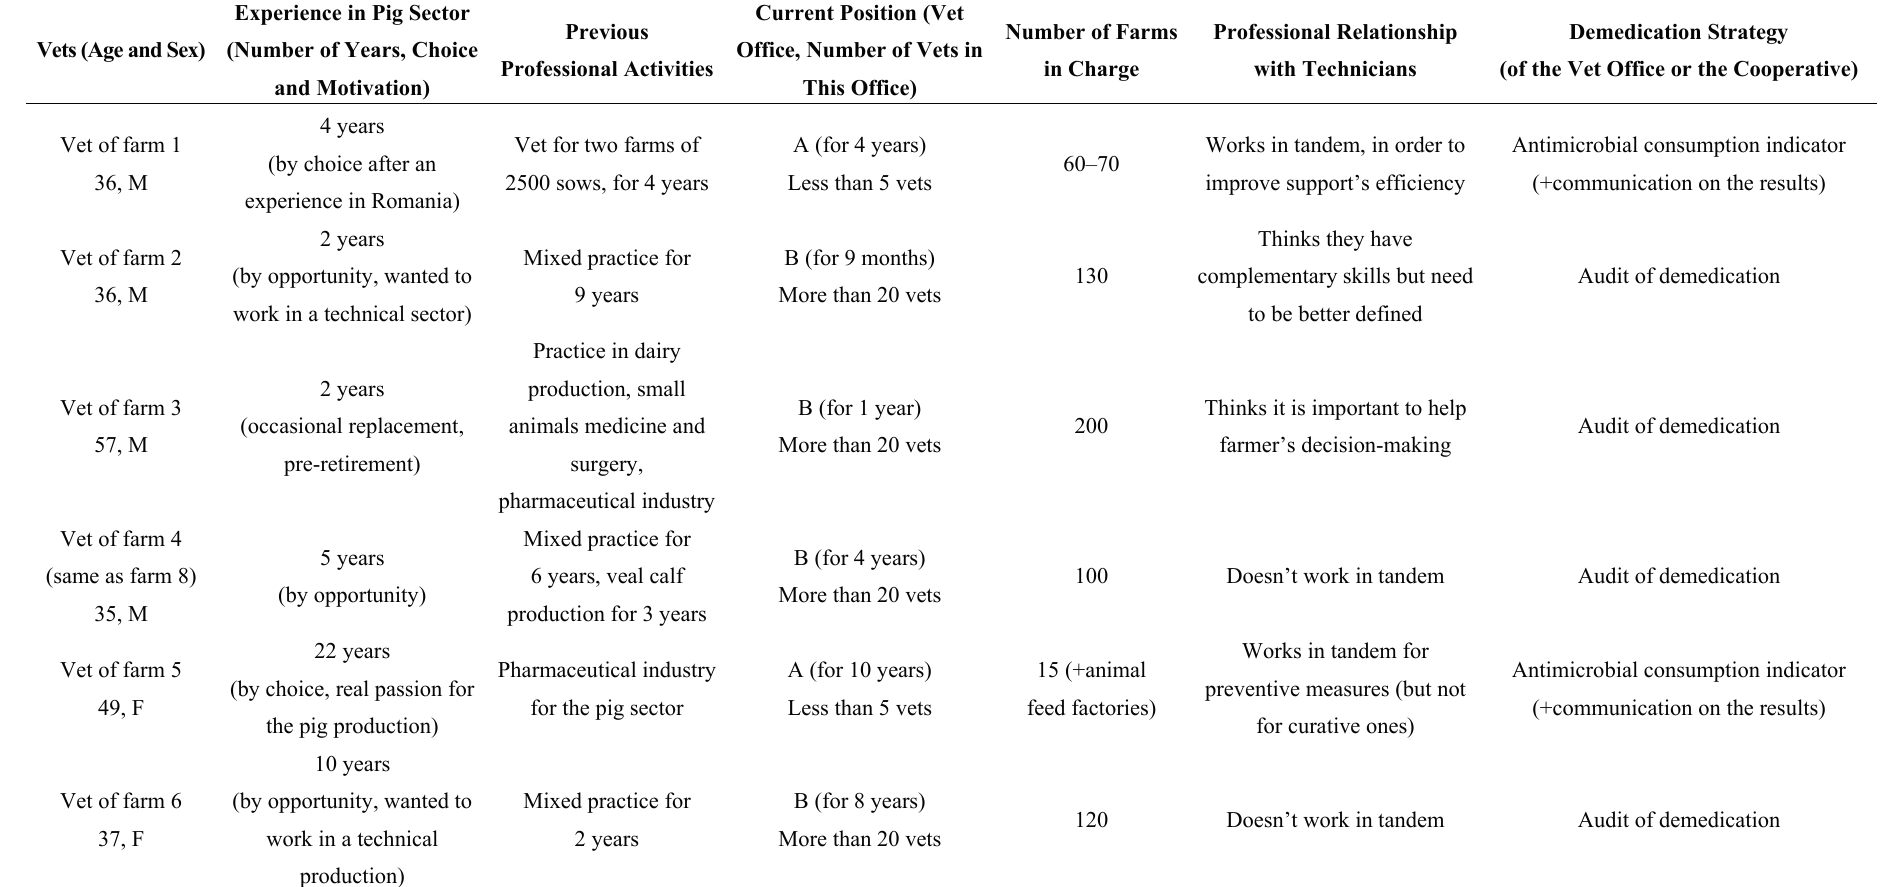
Table 2. Veterinarians’ characteristics and professional